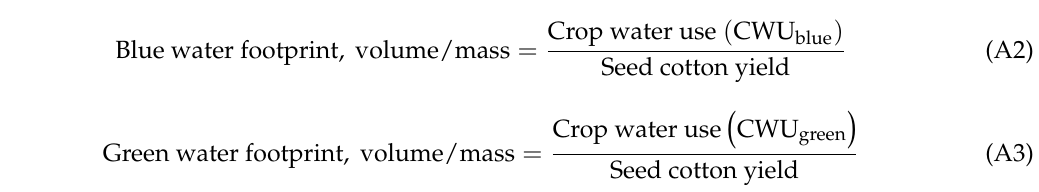
Table A6. Percentage of cotton grown in di ff erent regions of India, East and West Africa, Uzbekistan, Brazil, Turkmenistan, Egypt and China